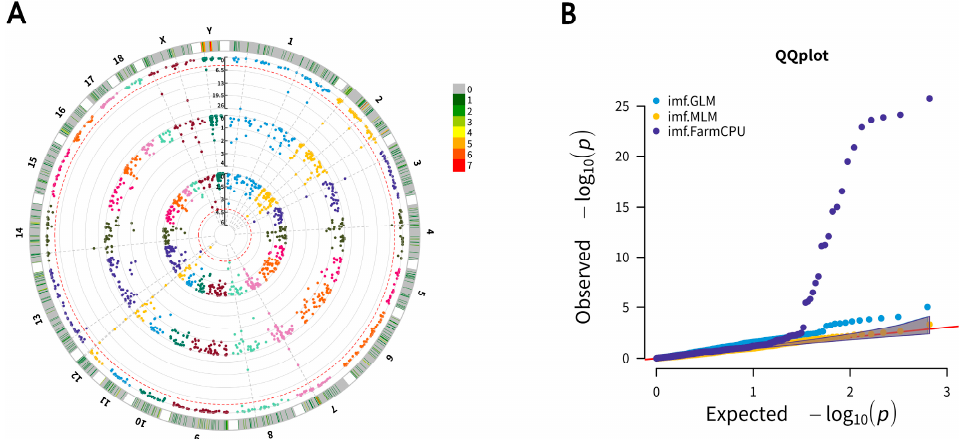
Figure 2. Circular Manhattan plot and quantile–quantile (QQ) plot of associated CNVs for IMF. ( A ) Circular Manhattan plot of associated CNVs for IMF using GLM, MLM, and FarmCPU methods; the outer circle is the number of CNVRs in the 1 Mb size region. Significant CNVRs in the same location are marked in lines; ( B ) QQ plot of CNVs associated with IMF using GLM, MLM, and Farm-CPU methods.